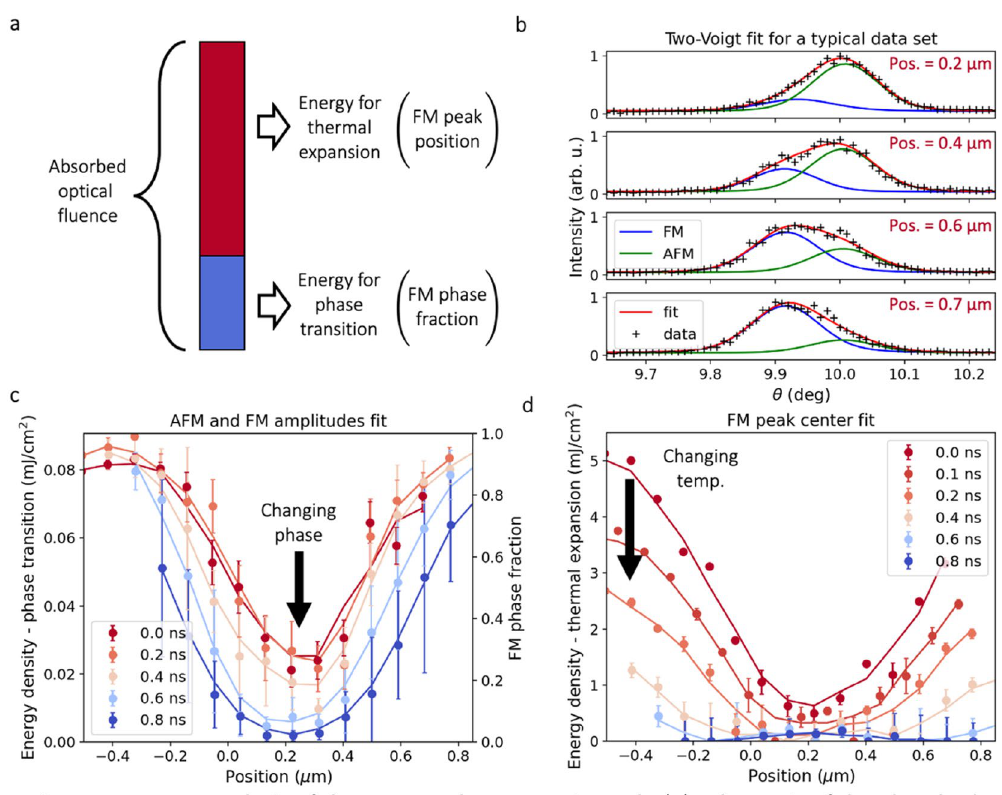
Figure 4. Energy analysis of the structural response in FeRh. ( a ) Schematic of the absorbed energy partitioning. Part of the absorbed fluence triggers the phase transition (tracked by Bragg peak amplitudes), and any excess energy heats the FM phase (tracked by the FM peak center). ( b ) Extraction of the FM phase fraction and FM angular maximum for several positions at t = 0. ( c ) FM phase fraction at each position and time, proportional to the energy density locally stored in the phase transition. ( d ) Local energy density remaining in the FM phase heated beyond T trans . The data at each subsequent time step in ( c,d ) are shifted by a constant amount such that the minima line up, accounting for the long-term spatial drift during the data collection. Solid lines are three-point smoothed data, accounting for the 270 nm spot size and 90 nm step size. Error bars are described in “Methods”